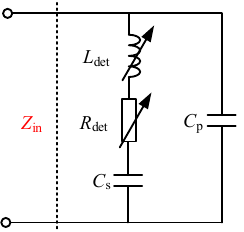
Figure 6. SP mixed resonance to amplify inductance variation.